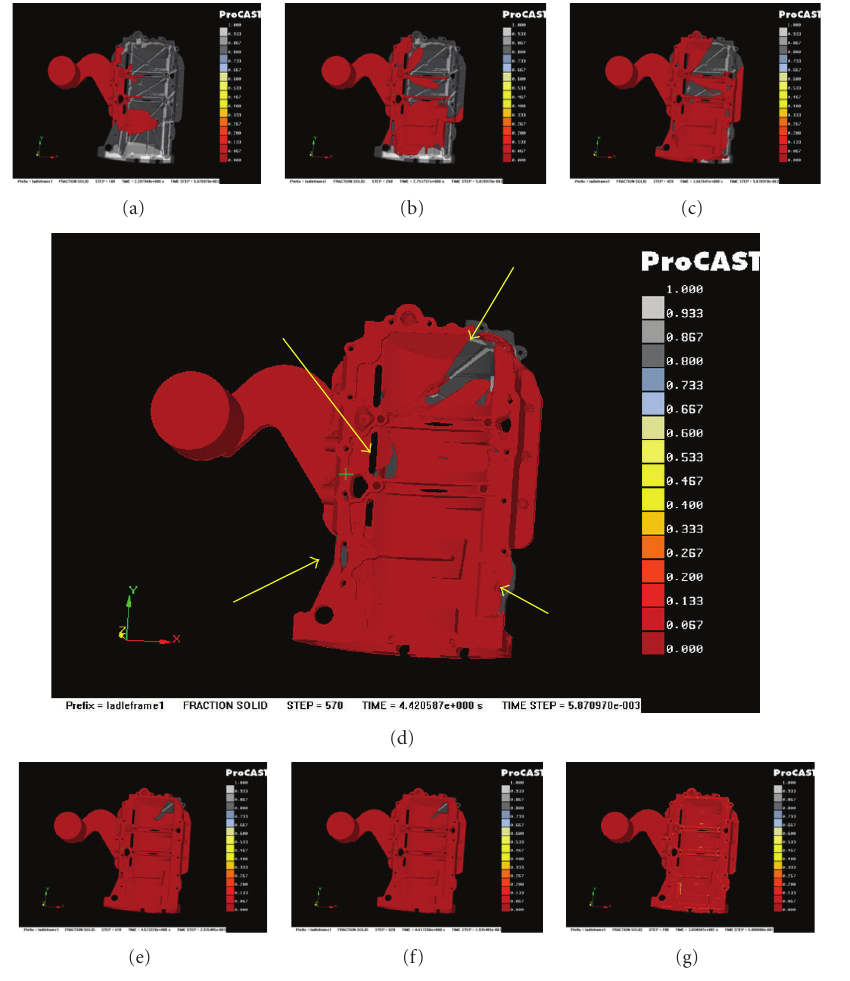
Figure 9: Steps filled die by the melt and show End